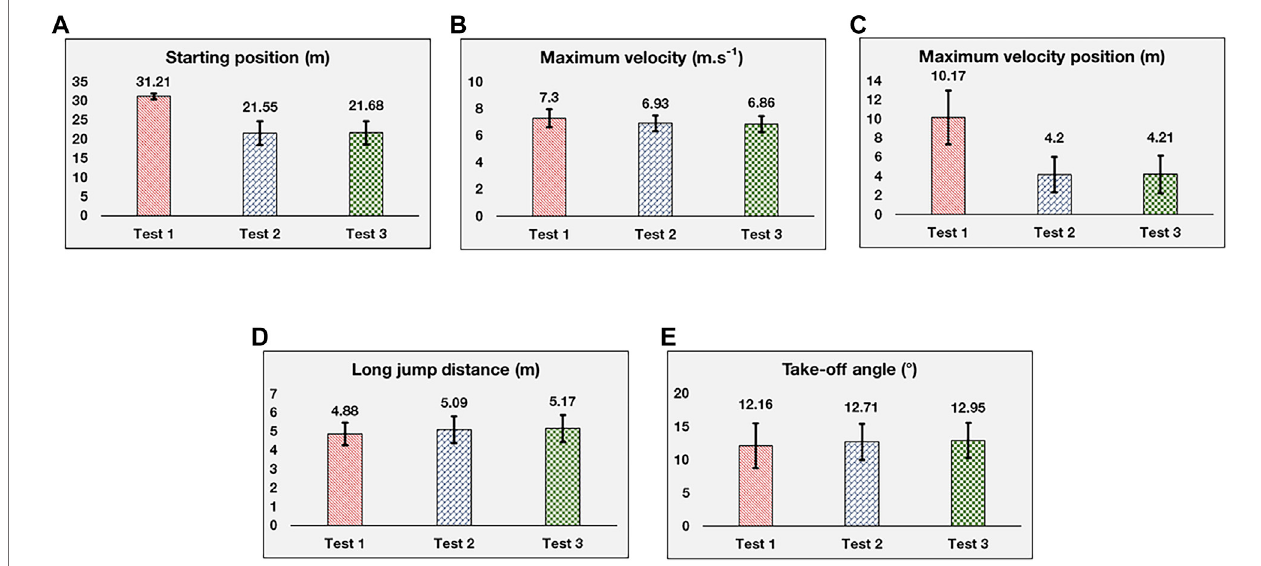
jump data from each student and then Algorithm 1 and Algorithm 2 calculated the long jump performance of the